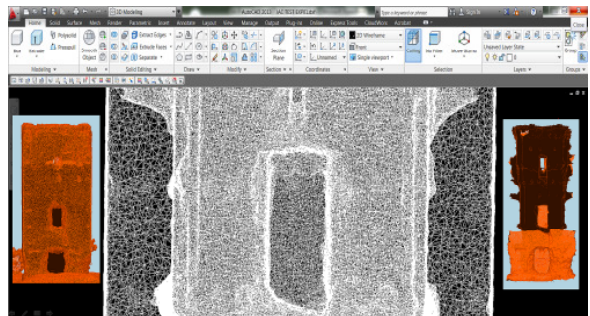
Figure 6. UAV outside and action-cam inside integrated